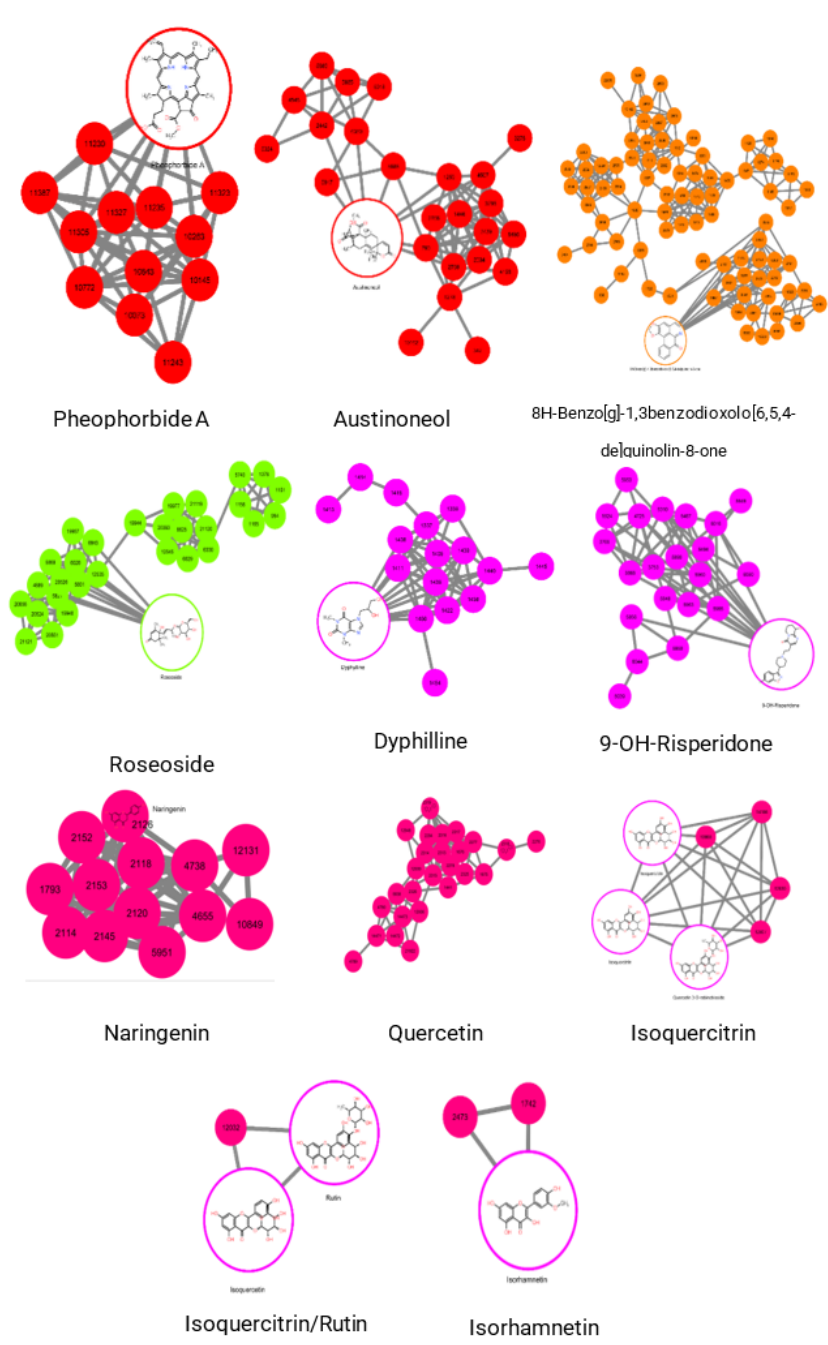
Figure 5. Identified putative compounds and their networks in the F15-16 and F15-17 fractions from Cytoscape analysis.